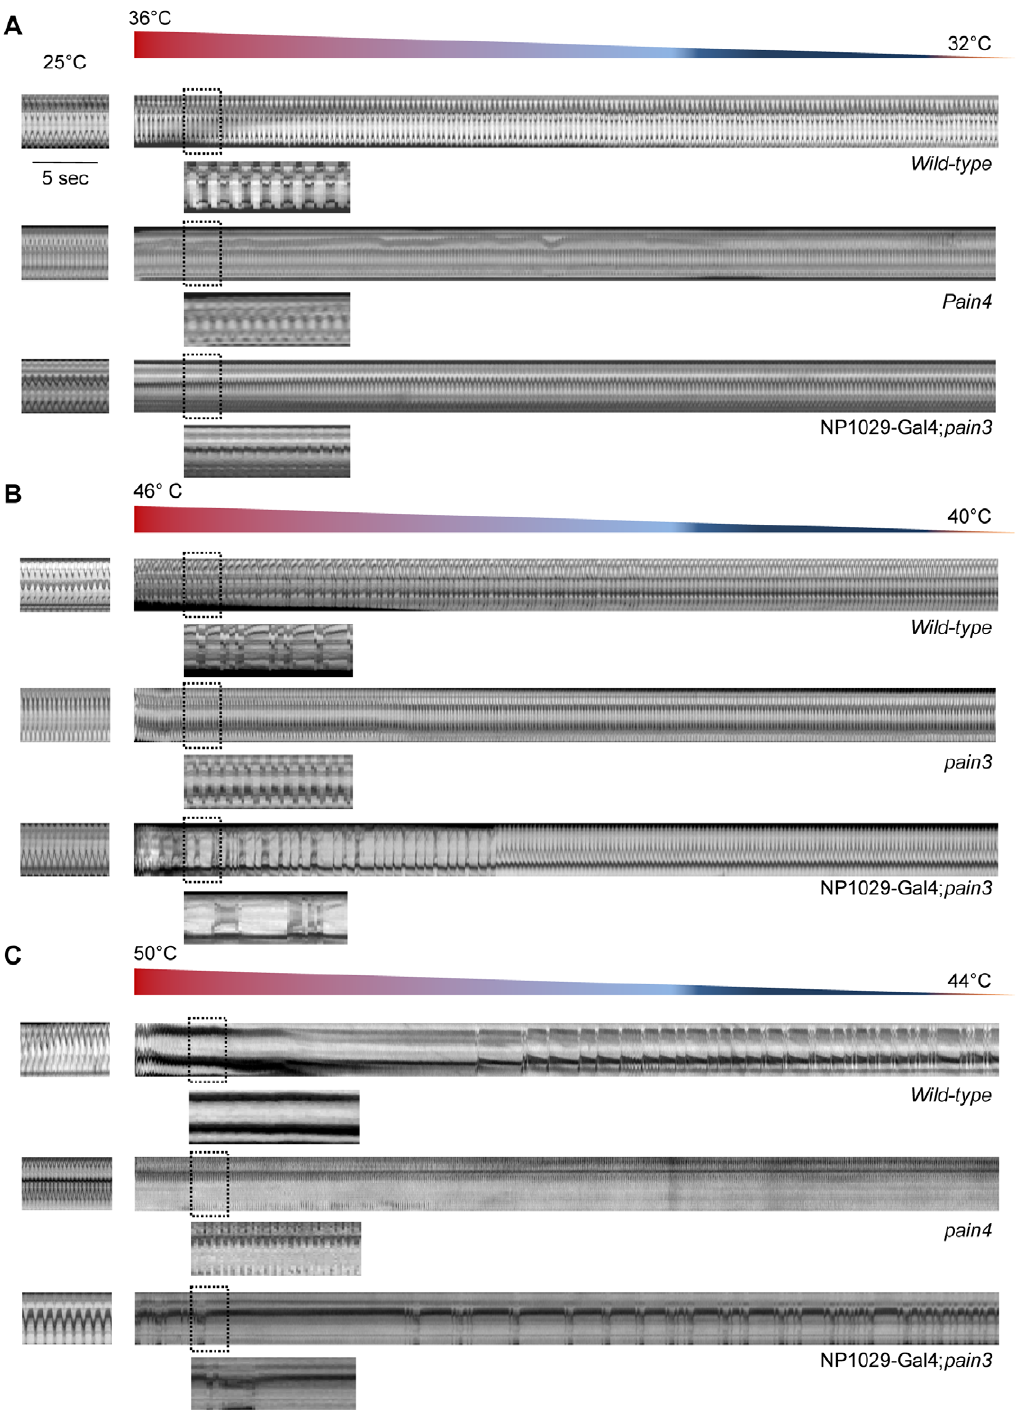
Figure 4. Cardiac response to Painless activation by elevated temperature. In all cases, semi-dissected preparations were first bathed in the Schneider medium at 25 u C (m-modes, left). Then, the temperature of the medium in the perfusion chamber was increased at the indicated values (m- modes, right). (A) M-mode traces from movies recorded after slight temperature increase. The heart rate of wild-type cardiac tube bathed in the medium at 25 u C is regular (160 bpm). When the temperature is increased to 36 u C, a 14.1% increase in frequency is observed. The same type of response is observed in the pain4 mutant (7.7%) and after transgenic rescue (12.2%). (B) M-mode traces from movies recorded after moderate temperature increase. In the wild-type, the increase of temperature from 25 u C to 46 u C induces a strong arrhythmia with an important decrease in the cardiac rate ( 2 23.7%). In pain3 individuals, the rise in temperature induces tachycardia (20.2%) but no arrhythmia was observed. The bradycardia and the associated arrhythmia observed in the wild-type are recovered in the pain3 rescue ( 2 18.5%). In both the wild-type and the rescue, the regular beating is progressively recovered when the temperature drops back. (C) M-mode traces from video-movies recorded during high temperature increase. In wild-type, increasing the temperature from 25 u C to 50 u C leads to a cardiac pause and the heart restarts to beat firstly irregularly, then the